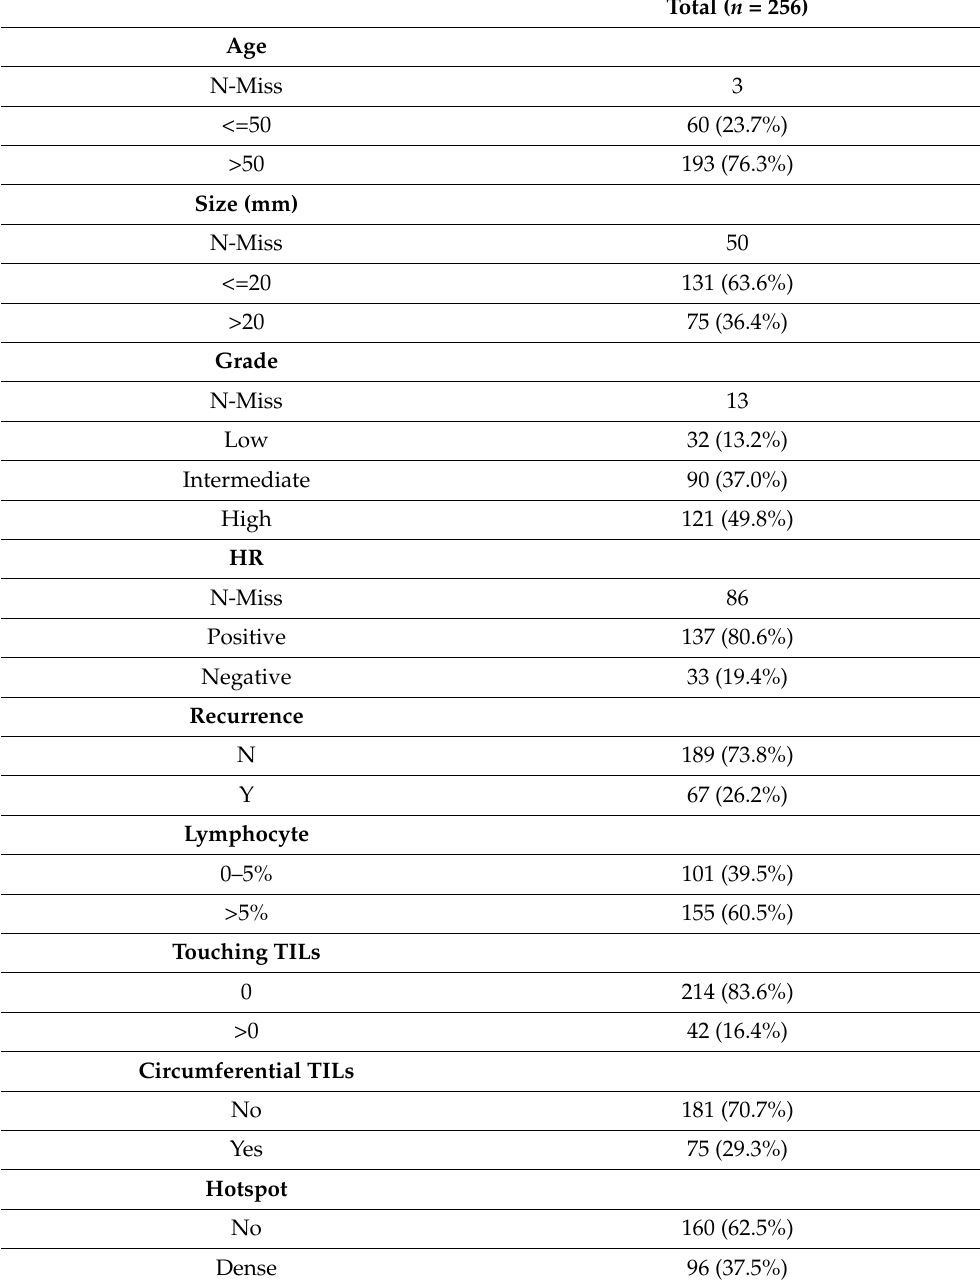
Table 1. Patient characteristics and association with TILs assessments for DCIS